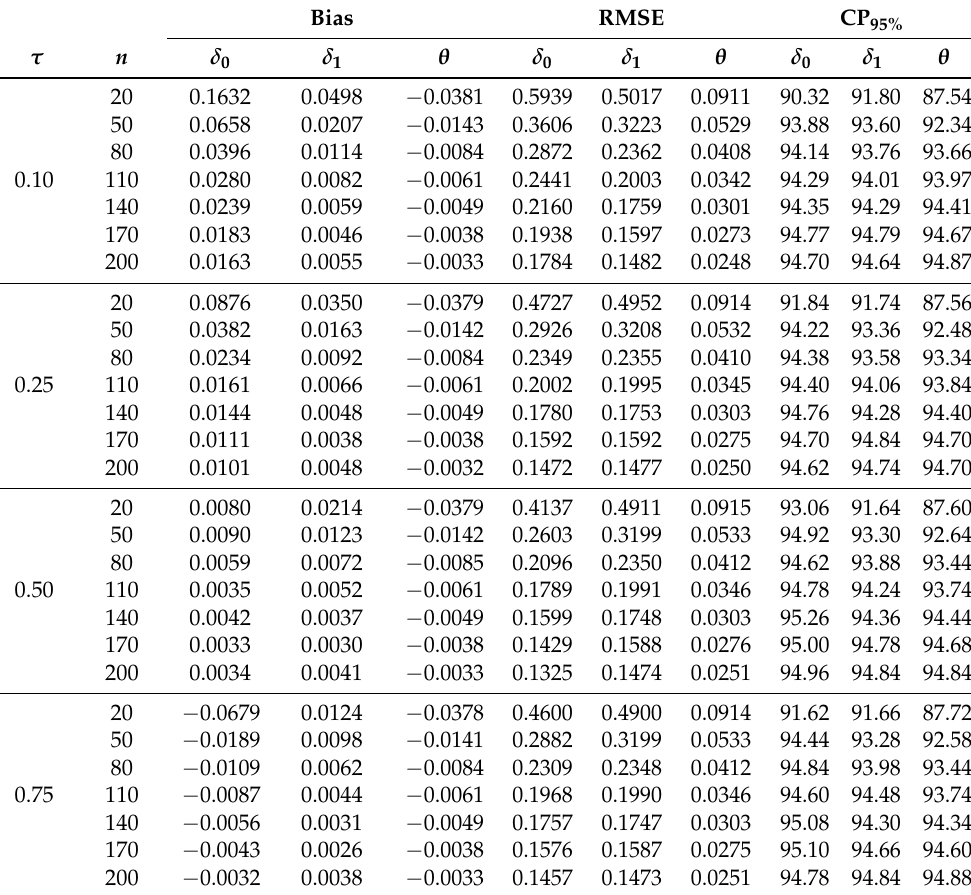
Table 2. Empirical bias, RMSE, and 95% CP (true values: δ 0 = 1.00, δ 1 = 2.00, and θ = 0.50) with simulated